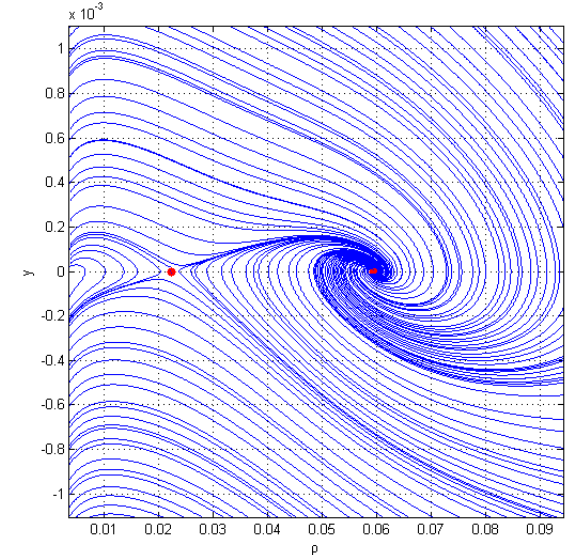
Fig. 2. Phase plane y-  trajectory diagram,where traveling wave velocity 38.1  c , traveling wave parameter 64.0q * 